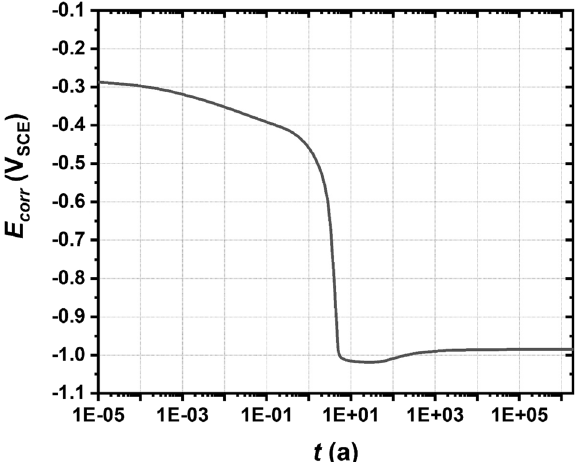
Table 2. Electrochemical and corresponding Butler – Volmer equations for Cu interfacial redox reactions under both oxic and anoxic conditions. Electrochemical reaction Butler – Volmer equation